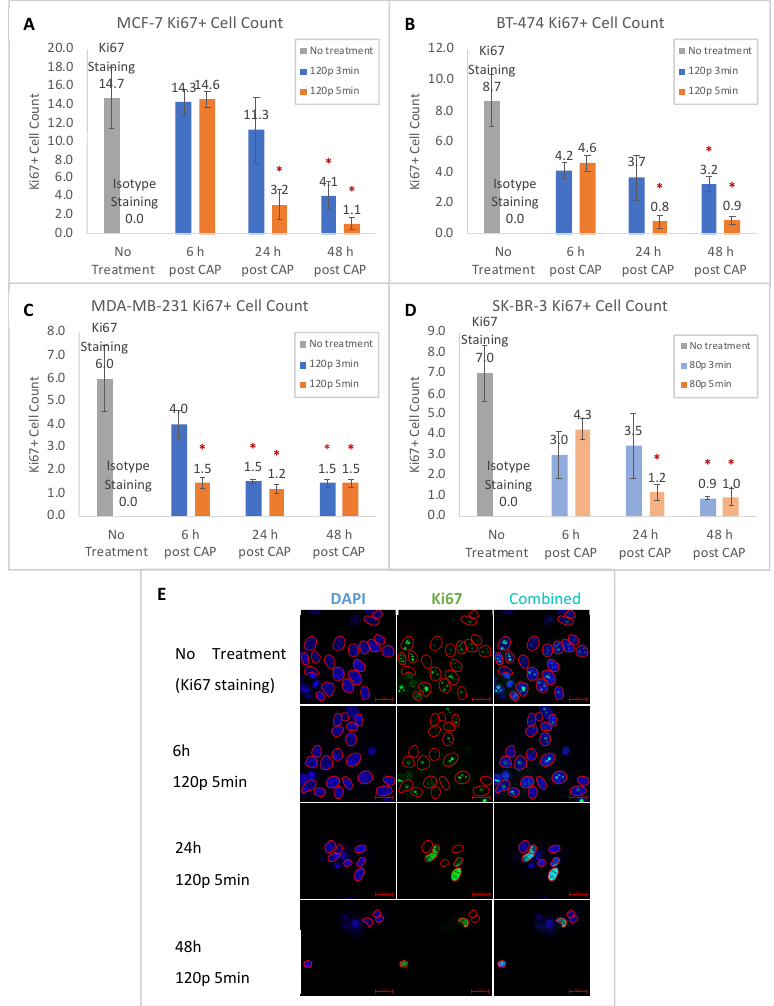
Figure 2. Averaged quantification plot of ‘Ki-67 + ’ cell counts of ( A ) MCF-7, ( B ) BT-474, ( C ) MDA-MB-231, and ( D ) SK-BR- 3 cells 6/24/48 h post-CHCP treatment at 120 or 80 P for 3 or 5 min. (* above the bars denotes statistical significance of CAP-treated group compared to NT. * p < 0.05). NT = No Treatment. ( E ) Representative confocal microscopic images of MCF-7 cells. NT or 6/24/48 h post-CAP treatment at 120 P for 5 min (Alexa Fluor 488 conjugated Ki-67 Rabbit mAb probe was shown in green, DAPI for nucleus staining was shown in blue. Scale bar 20 μ m). Ki-67 staining was remarkably brighter in cells with NT or with lower dosages of CHCP than those treated with higher dosages (Supplementary Figures S2 – S5). Taking MCF-7 as an example, Ki-67 was seen throughout the nucleoplasm, and in most cases in co-localization with nucleoli in NT samples. At low-dose or short incubation time (6 h of 120 P for 3 min and 5 min, 24 h of 120 P for 3 min, and 48 h of 120 P for 3 min), nucleoli were intact and Ki-67 expression was still observed but in fewer cells; at high dose (24 h